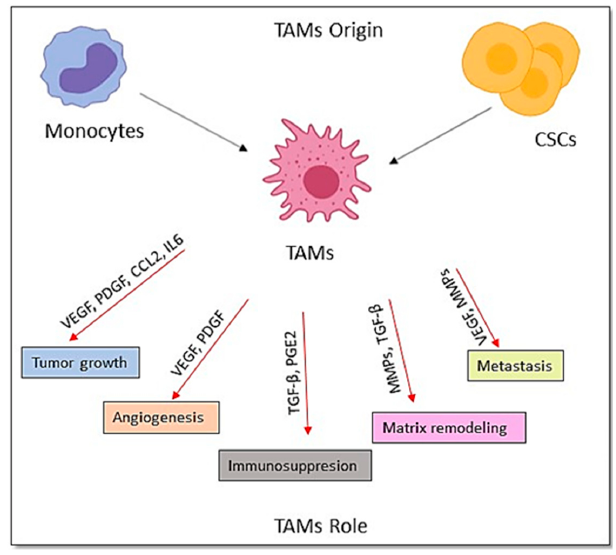
Figure 5. The origin and the roles of TAMs in the TME.